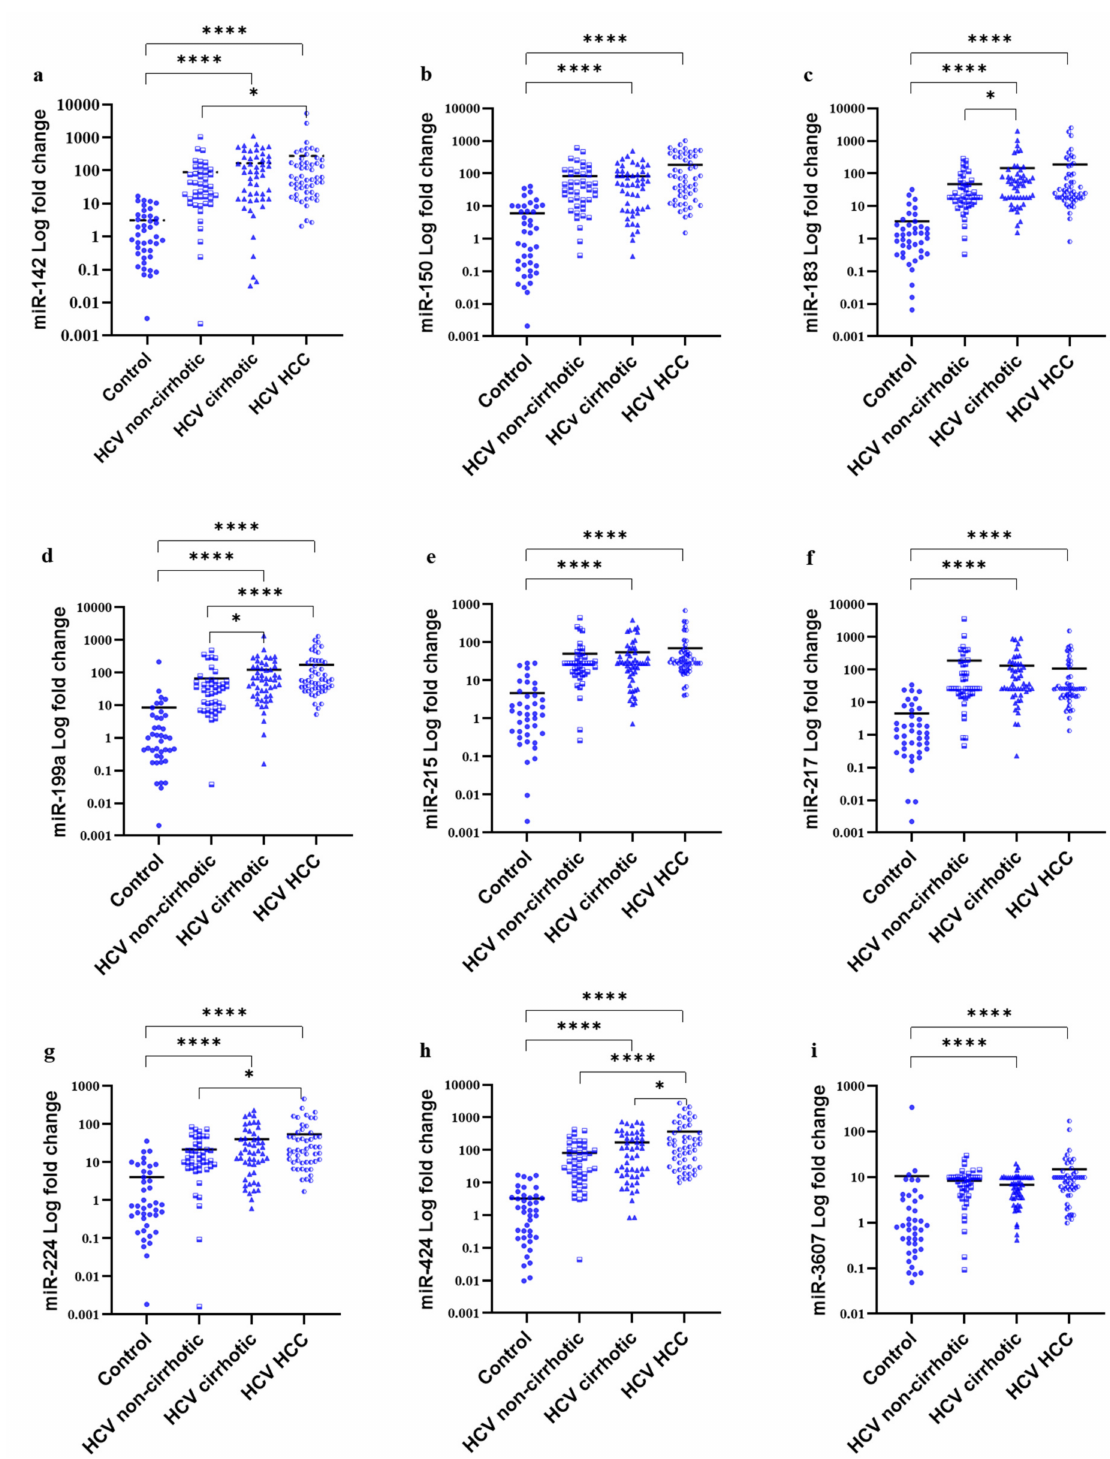
Figure 5. Fold change of the differentially expressed miRNAs in the study groups. Scatter dot plots demonstrating the fold change of serum expression of the target miRNAs [( a ) miR-142 ( b ) miR-150, the study groups. Y-axis represents the log of the fold change of each miRNA; X-axis shows the study groups. * Corresponds to significant p- value ≤ 0.05, **** corresponds to significant p- value < 0.0001. Each experiment was performed in duplicates (HCC: Hepatocellular